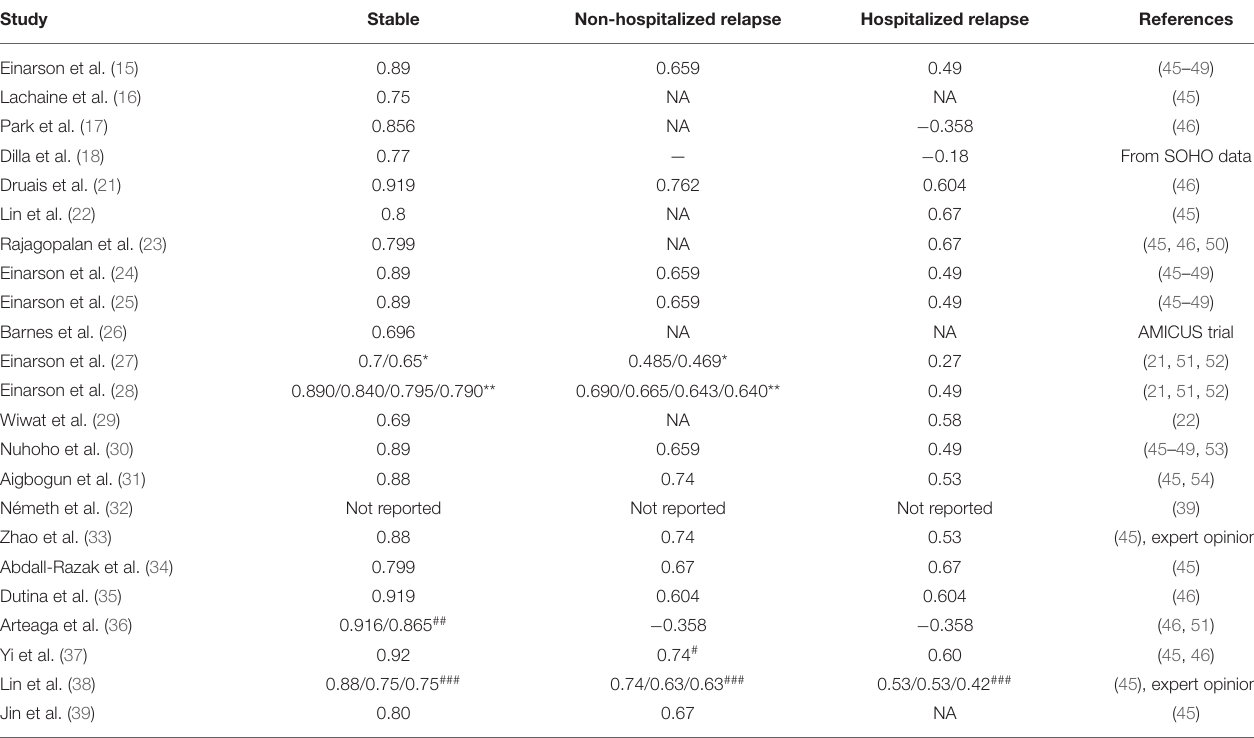
TABLE 6 | Summary of the utilities for health states of